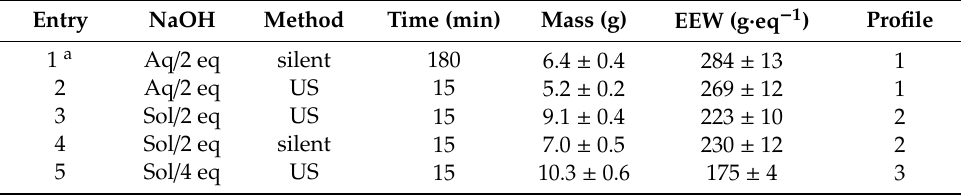
Table 1. Experimental conditions for the synthesis of oligo-isosorbide glycidyl ethers.